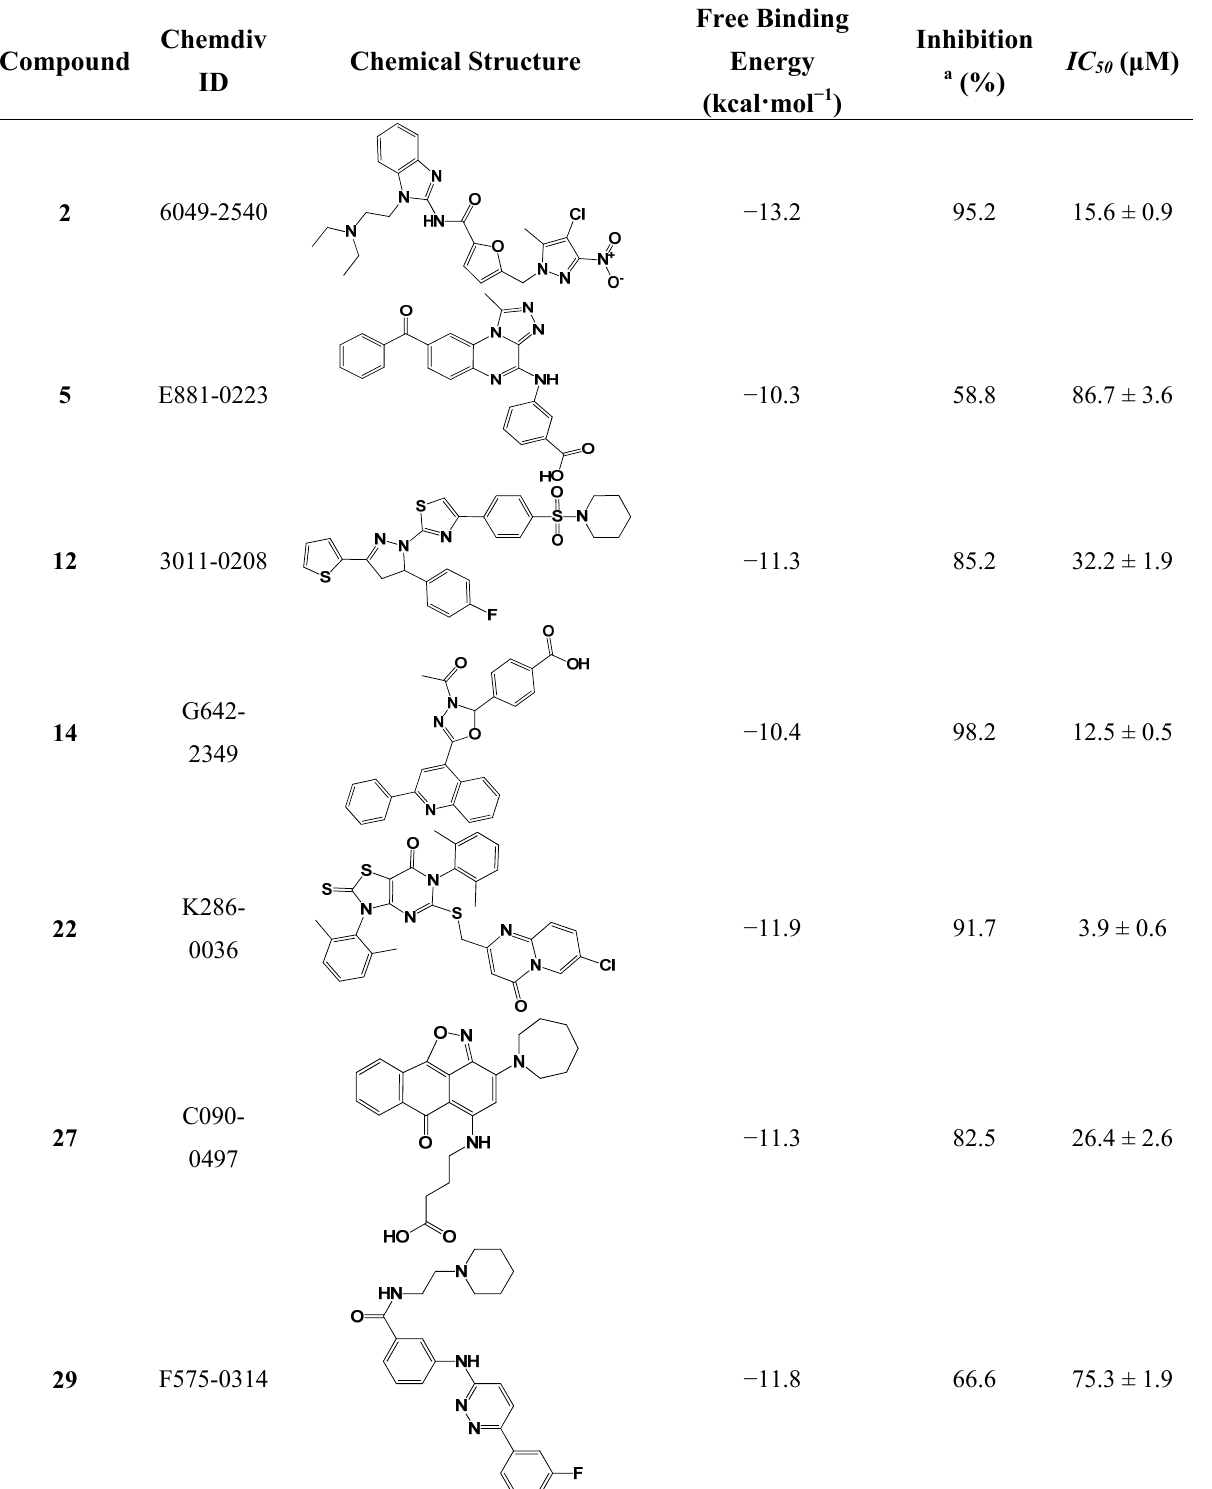
Table 2. Inhibitory activities of the identified compounds against recombinant NS2B-NS3 pro .